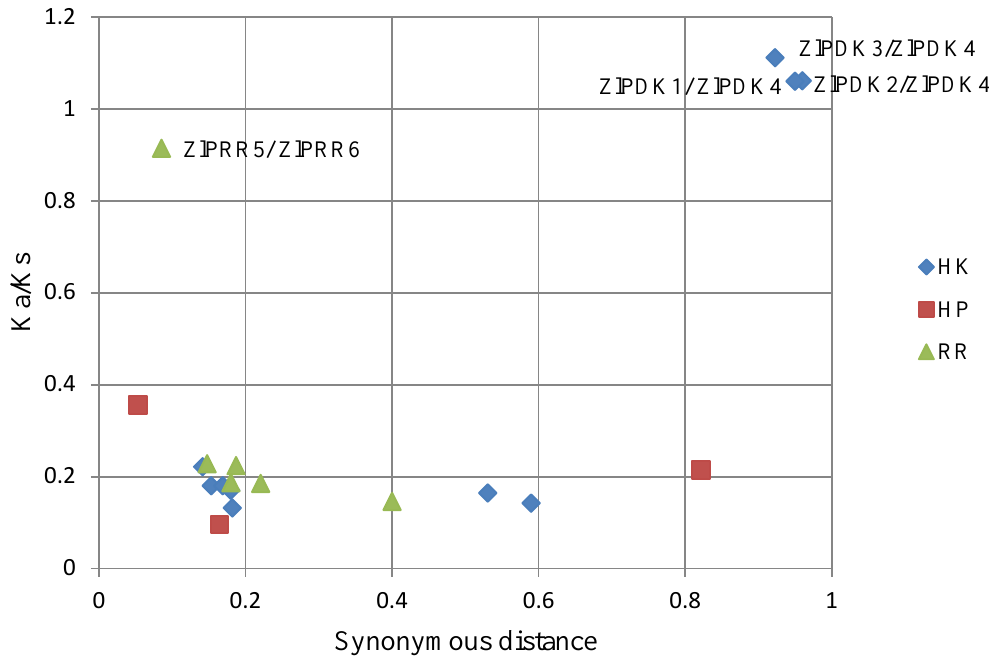
Figure 5. Scatter plots of the Ka / Ks ratios of duplicated two-component system (TCS) genes in Z. latifolia . The x-axis represents the synonymous distance and the y-axis represents the Ka / Ks ratio for each pair.